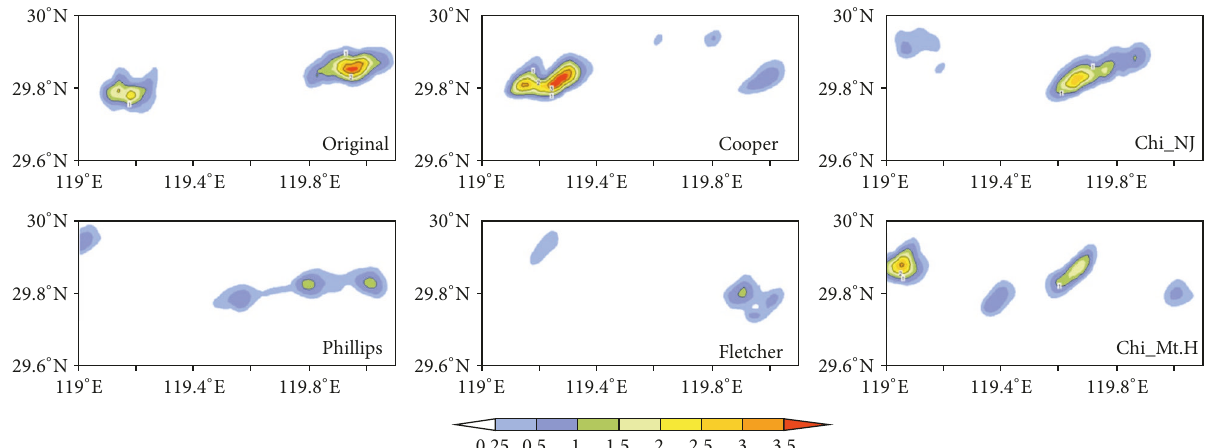
Figure 5: Case study 09: Simulated ground cumulative hail volume in the Pujiang area at 17:00 CST based on different simulations (unit: